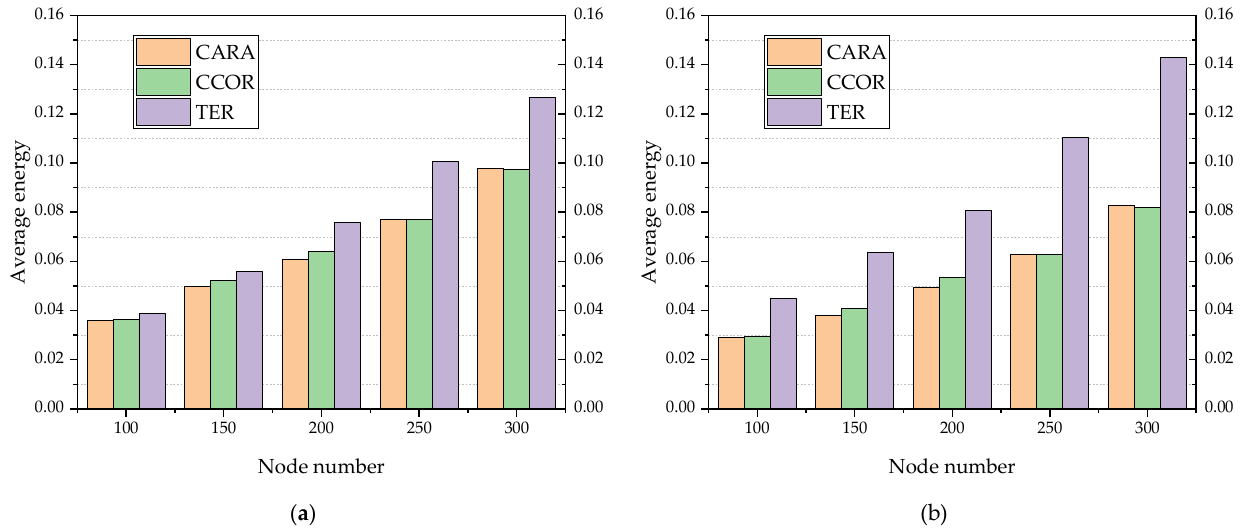
Figure 5. The average energy consumption (mJ) with the number of nodes. ( a ) Cache queue lengths = 20; ( b ) cache queue lengths = 30.